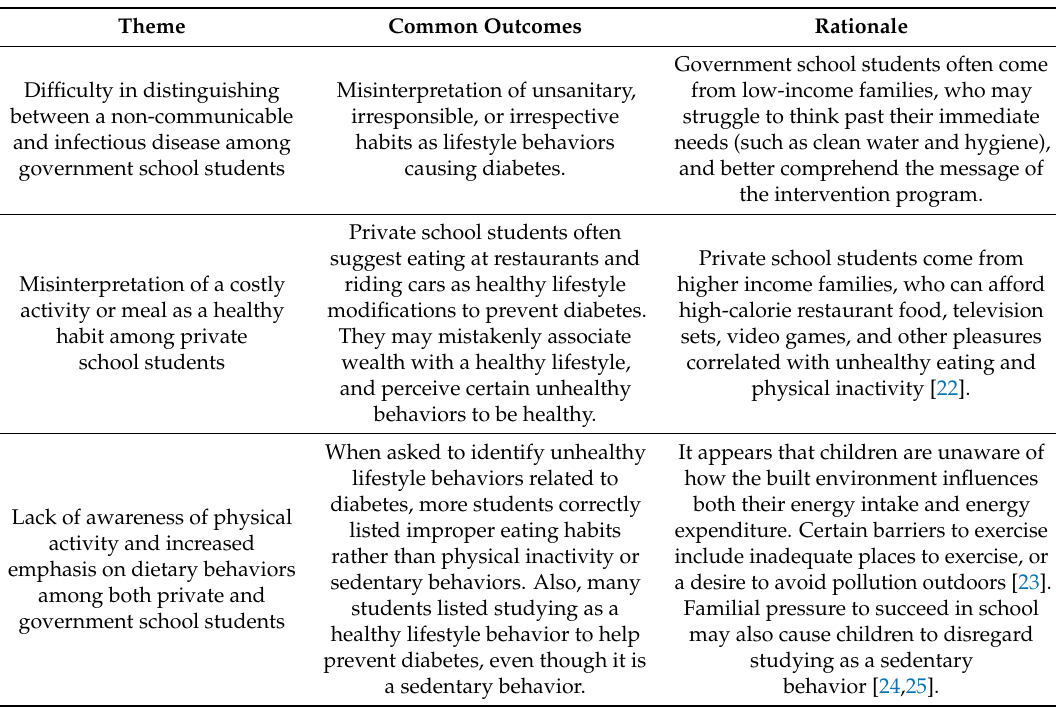
Table 3. Emergent themes from the ORANGE Phase II intervention